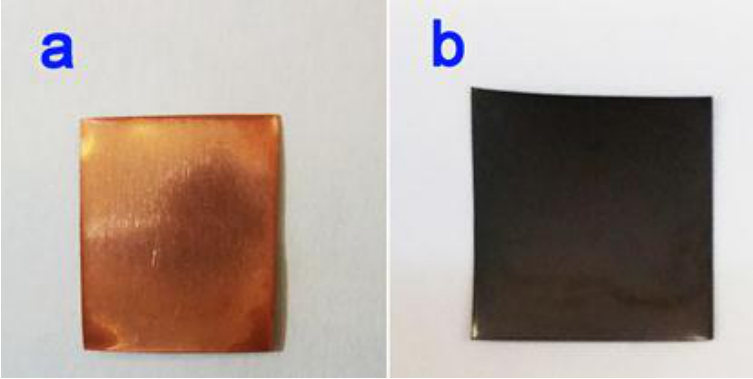
Figure 1. The appearance of the Cu foils between the different stages treatments. ( a ) the cleaned Cu foil; ( b ) the Cu foil reacted with EG at 80 ◦ C for 5 days.